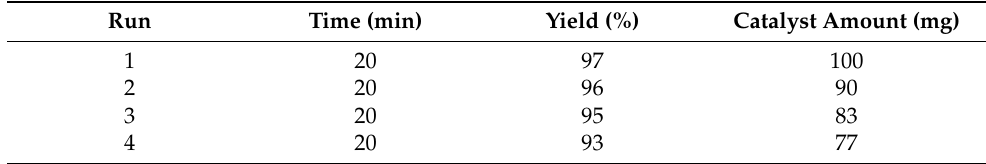
Table 6. Reusability studies of the 1%Pd-HPW/SiO 2 catalyst a . Run Time (min) Yield (%) Catalyst Amount